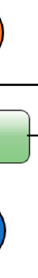
Figure 28. The structure of basic Recurrent Neural Network (RNN) with a loop.